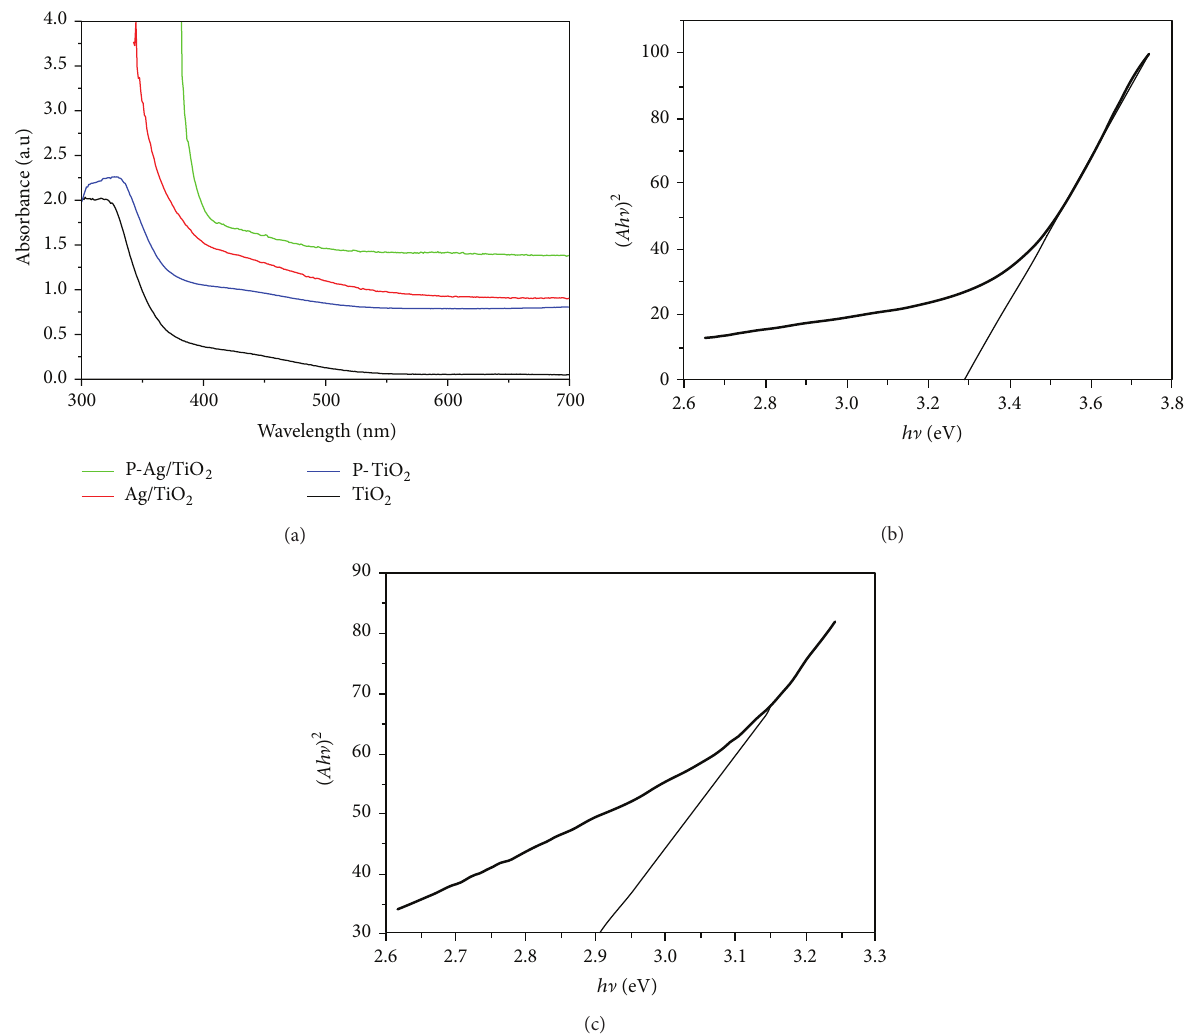
Figure 3: (a) UV-Vis spectra for TiO 2 , Ag/TiO 2 , P-TiO 2 , and P-Ag/TiO 2 . Band gap estimation for (b) TiO 2 and (c) Ag/TiO 2 .